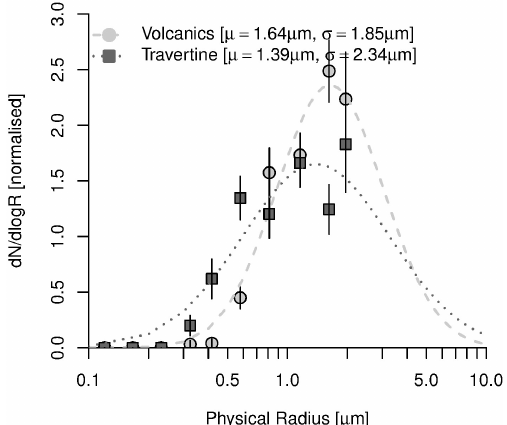
Figure 5. Probability density function fitted to log-normal distribu- tion of the volcanics and travertine PM 10 dust. Error bars represent uncertainties of bin